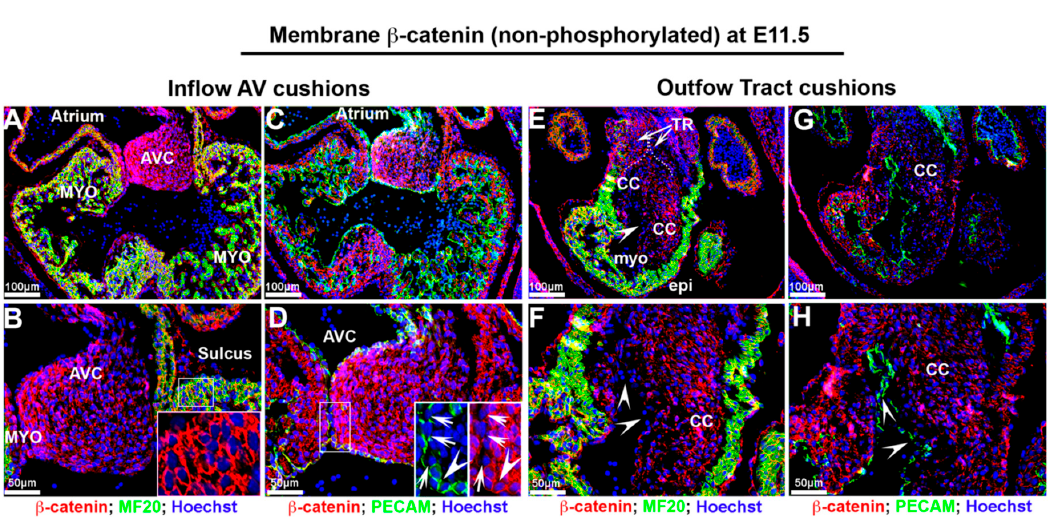
Figure 3. Non-phosphorylated β -catenin expression at E11.5 embryonic cardiac development. ( A , B ) Non-phosphorylated membrane β -catenin (red) was observed in developing atrioventricular cushions (AVC) with a gradient of staining intensity within the cushions. The myocardium (myo) exhibits robust membrane staining (( B )—boxed region). ( C , D ) Both Pecam and non-phosphorylated membrane β -catenin expression were dysregulated, and staining intensity was reduced at the area where the major cushions fuse (( D )—boxed region). ( E , F ) In outflow tract, membrane β -catenin displayed lower intensity in endocardium within conal cushions. ( G , H ) Pecam labeled endocardium showed lower to undetectable membrane β -catenin expression (arrowheads). TR = truncal ridges, CC = conal cushions.